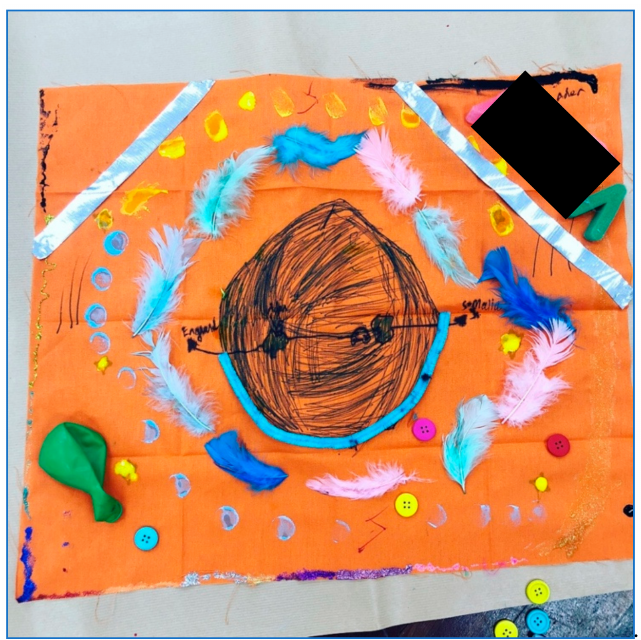
Figure 5. Expressive representation of migration from Somalia to the UK drawn by a South East London boy. RMIT University Human Ethics Clearance Number